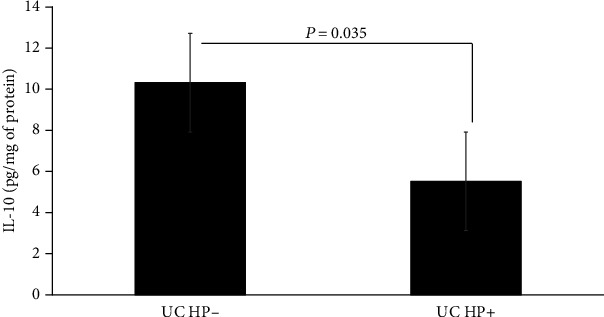
Serological levels of IL-10 in patients with UC in relation to their 13C-urea breath test result.